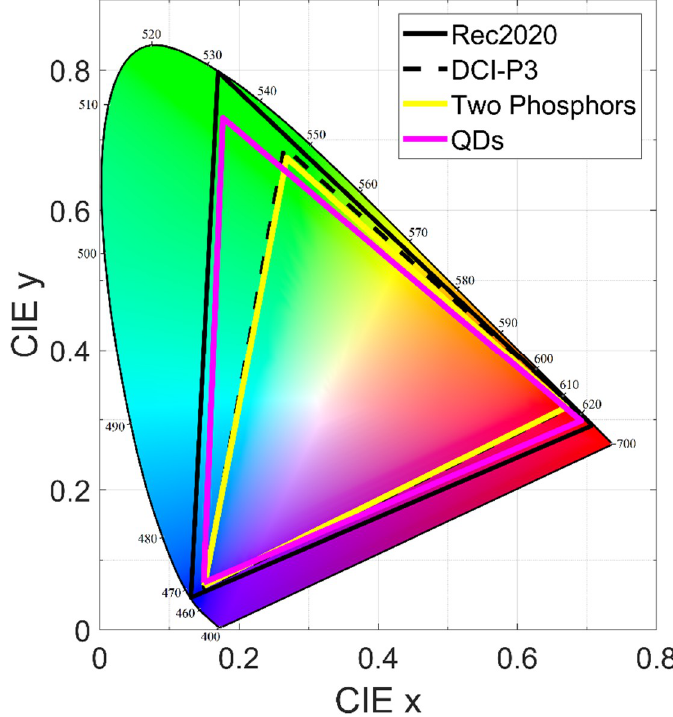
Figure 10. Simulated color gamut for device B with two phosphors (green: β -sialon:Eu + , red: K 2 SiF 6 :Mn 4+ ) and red/green quantum dots (QDs) in CIE 1931 color space.